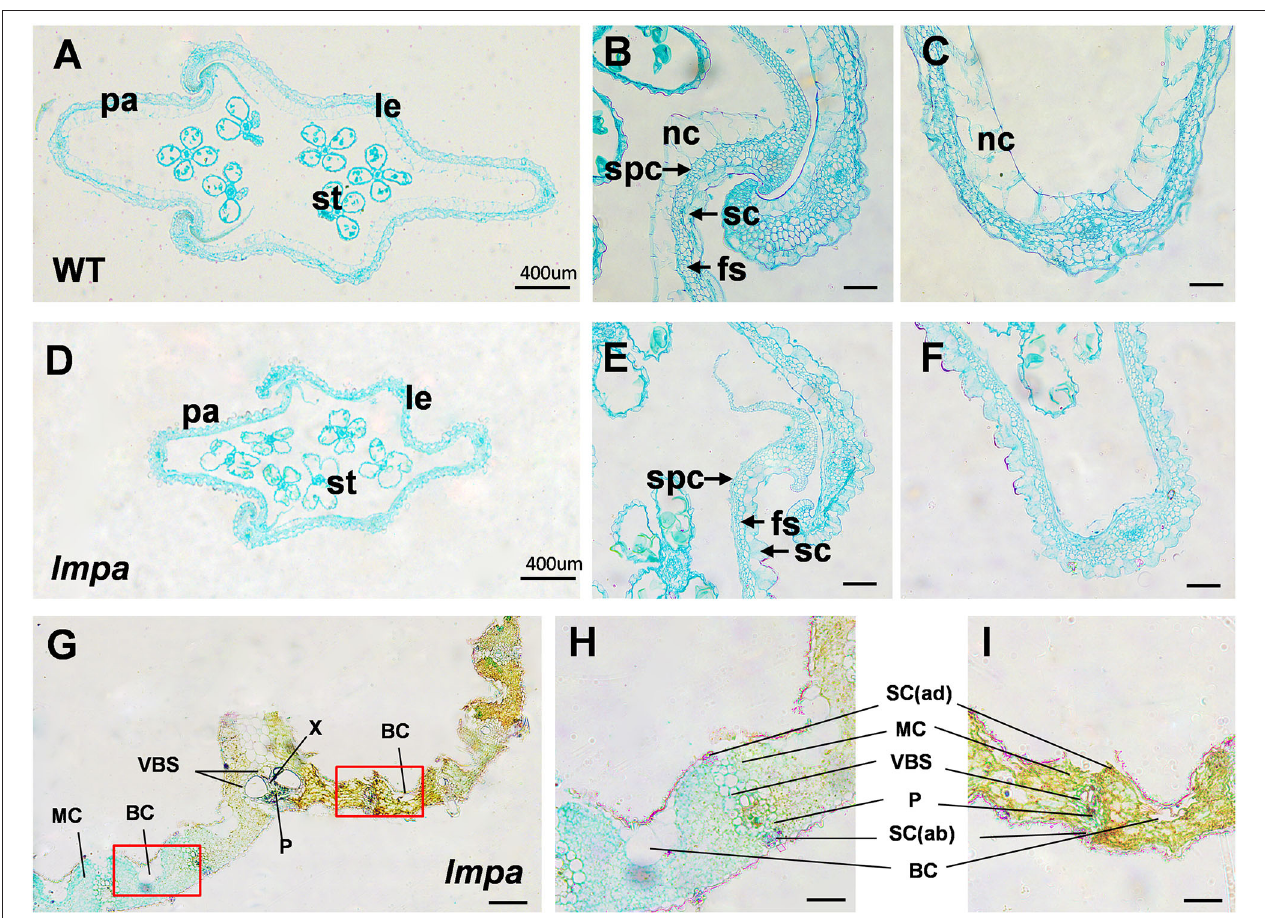
FIGURE 2 | Histological characterization of WT and lmpa mutant. (A–C) Cross-sections of WT apical spikelet hulls. (D–F) Cross-sections of lmpa apical spikelet hulls. (G) Cross-sections of lmpa leaves. (H) Normal part of lmpa leaves, magnified view of the white boxed areas in (G) . (I) Spotted part of lmpa leaves, magnified view of the white boxed areas in (G) . le, lemma; pa, palea; st, stamen; sc, silicified cells; nc, non-silicified cells; fs, fibrous sclerenchyma; spc, spongy parenchymatous cells. SC(ab), abaxial sclerenchyma; BC, bulliform cells; P, phloem; X, xylem; VBS, vascular bundle sheath; MC, mesophyll cells; SC(ad), adaxial sclerenchyma. Bars = 400 µ m in (A,D,G) , 50 µ m in (B,C,E,F,H,I)